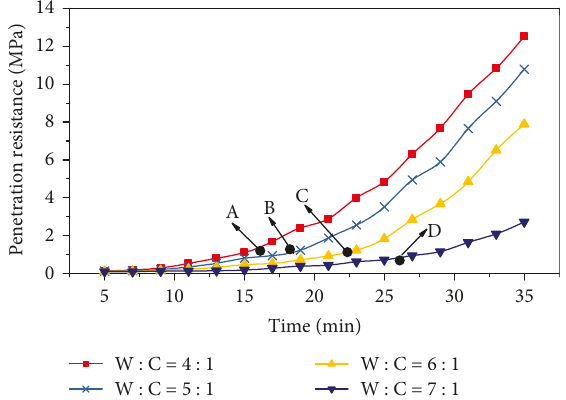
Figure 6: Initial setting time-penetration